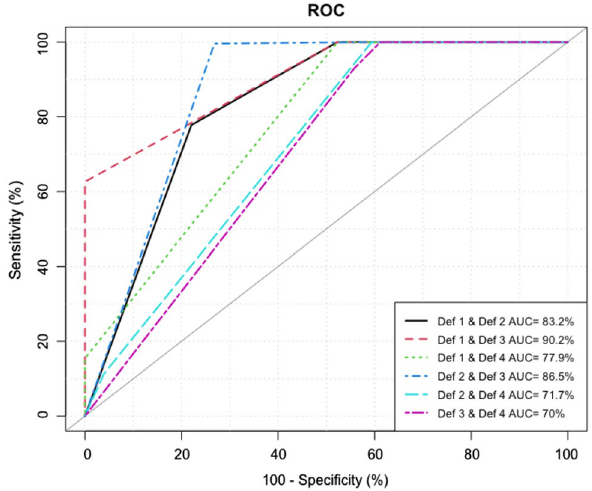
Fig. 2 ROC-AUC for all possible definition